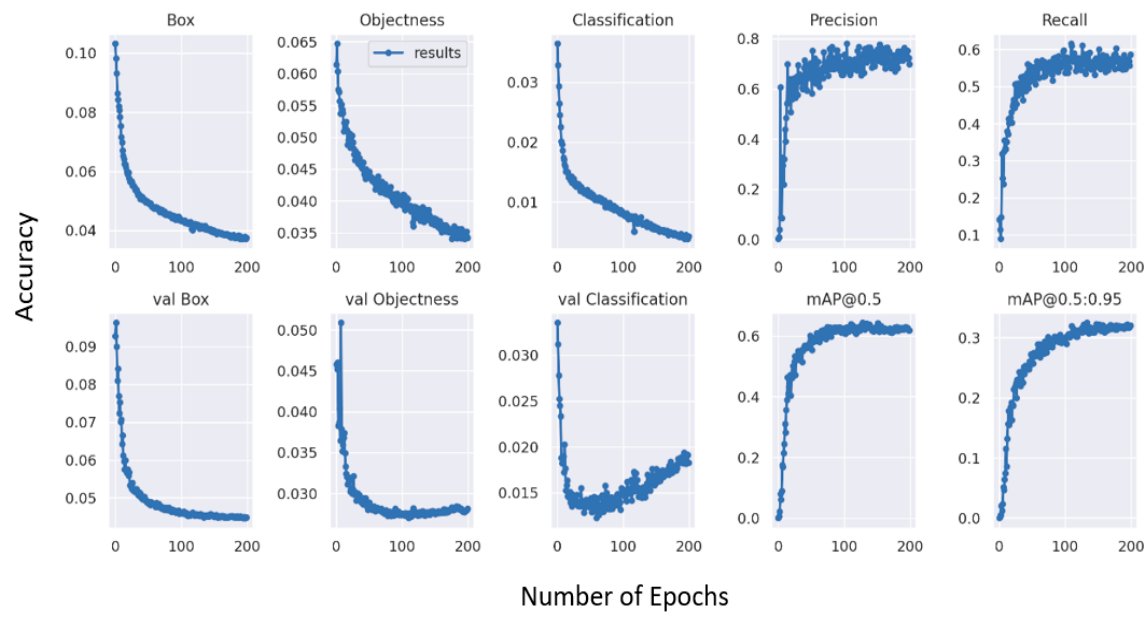
Figure 8. Training Figure 8. Training results. Table 2. Best mAP@0.5 and mAP@0.95 performance parameters results.